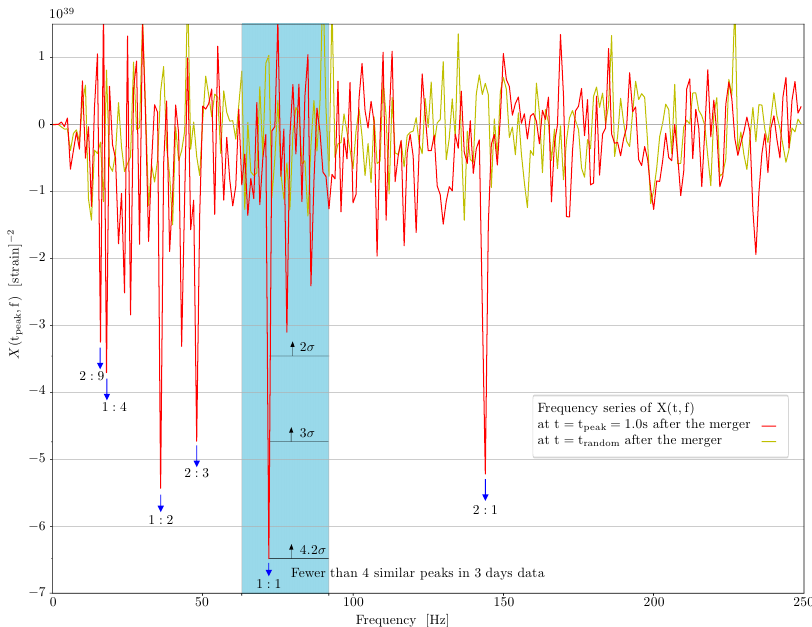
Figure 24. Amplitude-frequency plot of X ( t , f ) (Equation (154); combining all harmonics with N ) for the first peak (red) at 1.0 sec after the merger for the BNS merger frequencies n f , with n × ∈ gravitational-wave event GW170817, observed by x-correlating the LIGO detectors [20]. The same amplitude-frequency plot for a random time in data (yellow), is also shown for comparison. Solid area between 63 Hz and 92 Hz was the search frequency prior range for Planckian echoes.